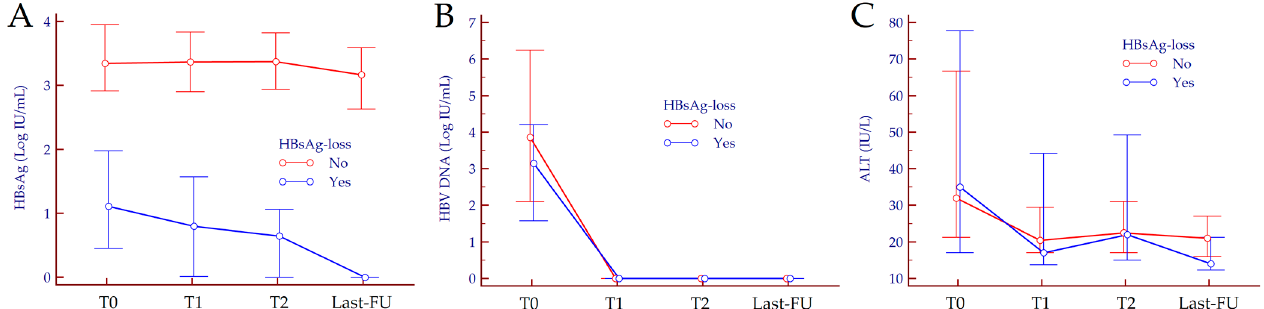
Figure 1. HBsAg ( A ), HBV DNA ( B ) and ALT ( C ) kinetics in patients achieving a functional cure and those with no HBsAg-loss. In both groups, HBsAg, HBV DNA, and ALT levels significantly declined from T0 to the last FU (Friedman test, p < 0.001). Data are depicted as the median and interquartile range. Abbreviations–alanine aminotransferase (ALT), follow-